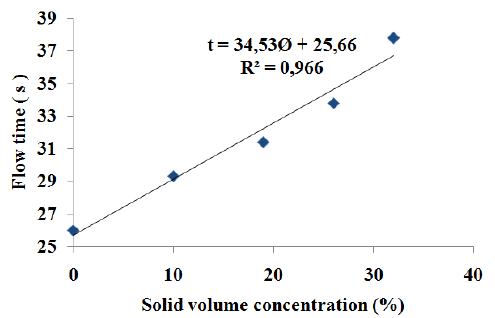
Figure 14: Influence of solid volume concentration on the flow time of LF